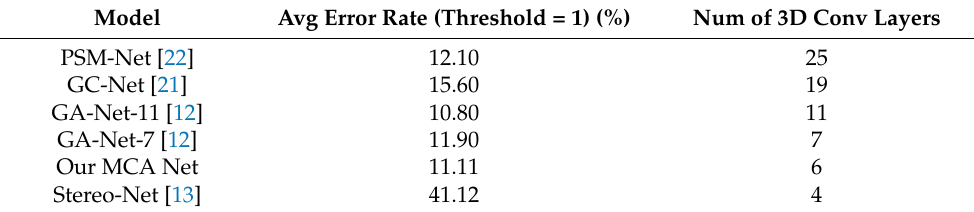
Table 3. Test results on Scene